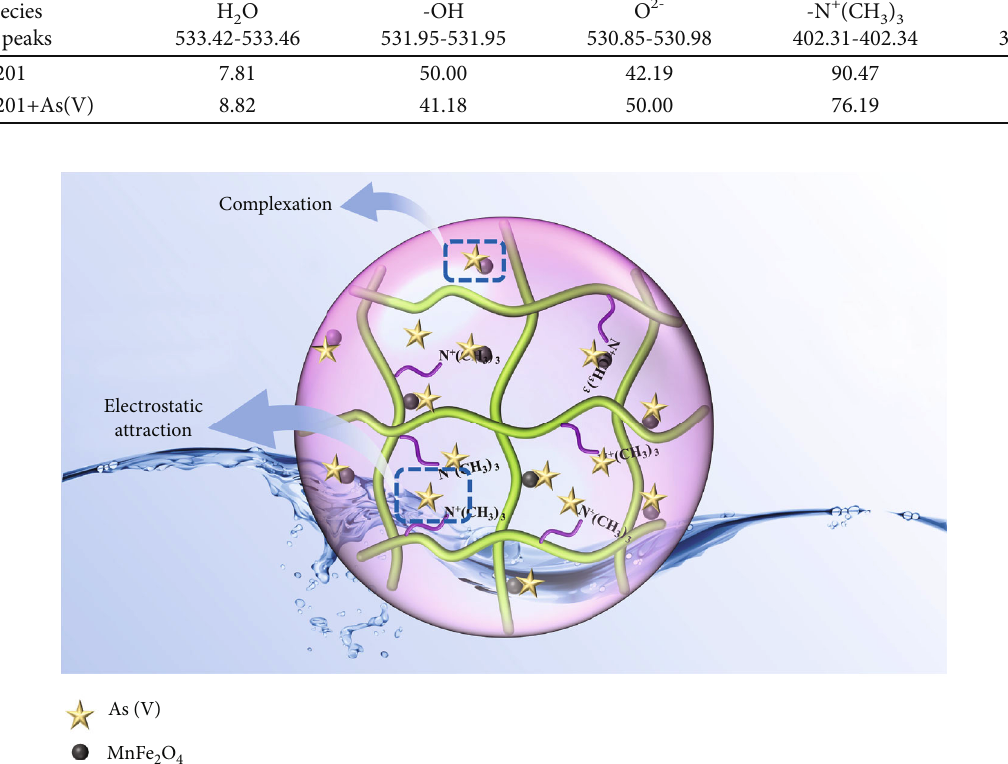
Figure 9: The schematic diagram of adsorption mechanism.